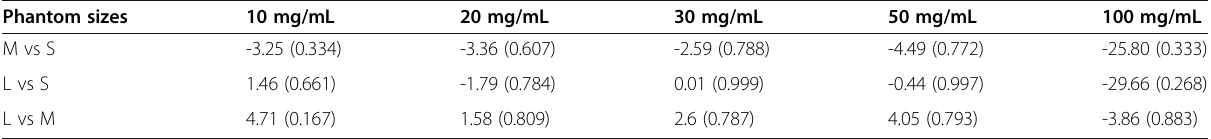
Table 7 Mean difference in HU values between phantom sizes for all monoenergetic images and iodine concentrations with Siemens Somatom Drive Phantom sizes